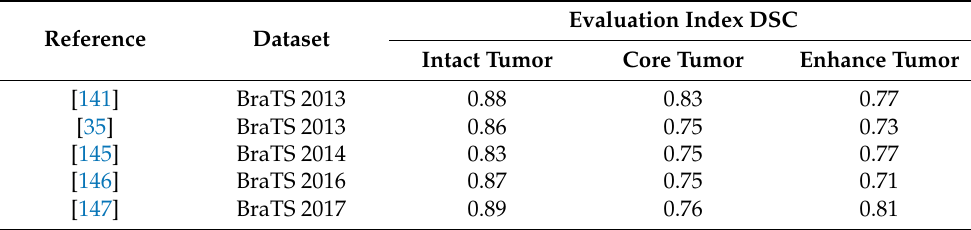
Table 4. Evaluation results of MRI brain tumor segmentation based on single CNN network.